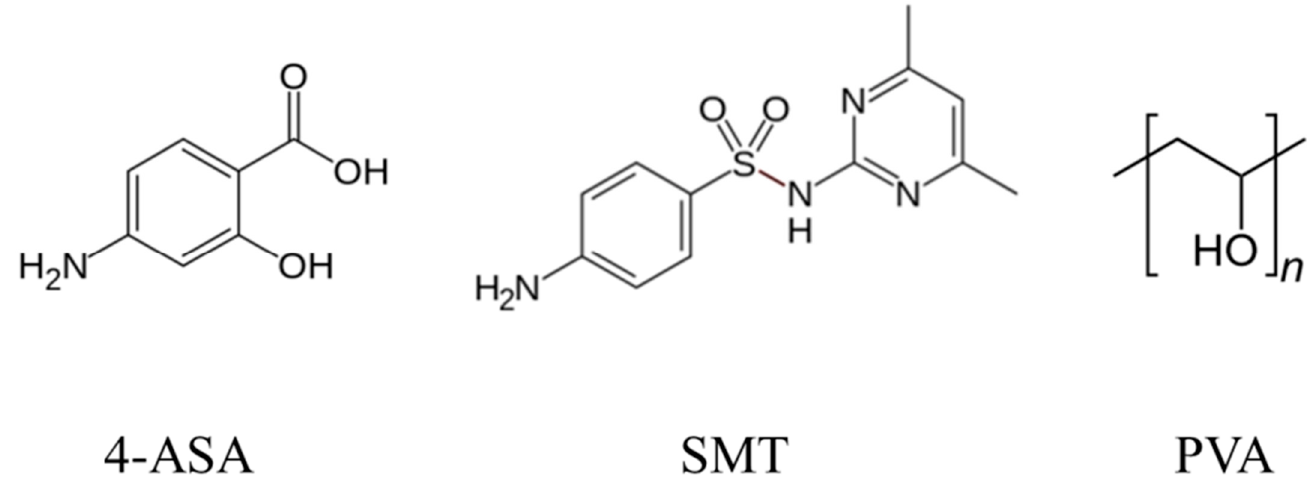
Figure 1. Active pharmaceutical ingredients (APIs) and the stabilizer used to prepare the cocrystals. 4-ASA: 4-aminosalysilic acid; SMT: sulfamethazine; PVA: polyvinyl alcohol.